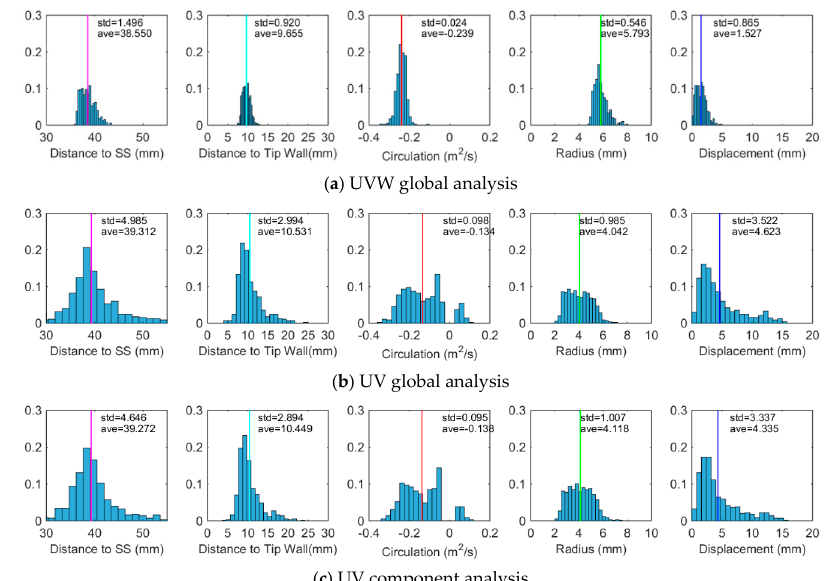
Figure 21 . Statistics of instantaneous reconstructed flow field that represents 95% energy fraction of the original flow field at L/c = 1.1. Note that the parameters from left side to the right are the distance of the TLV core center to the suction side, the distance of the TLV core center to the cascade tip wall, the TLV vortex circulation, the TLV vortex core radius and the distance of instantaneous TLV core center to the time-averaged TLV core center respectively. ‘std’ and ‘ave’ in the figure show the standard deviation and time-averaged value respectively. Figure 22 and Figure 23 show the corresponding reconstruction results using the first ten modes. The vortex distributions in the reconstructed flow field using different decomposition dimensionalities show the same concentrated characteristics. The histograms of these three analyses have the same shape as well. Though the addition of W velocity component does change the spatial structures of high-order modes, it does not change the dynamic results of reconstruction using the same number of POD modes.